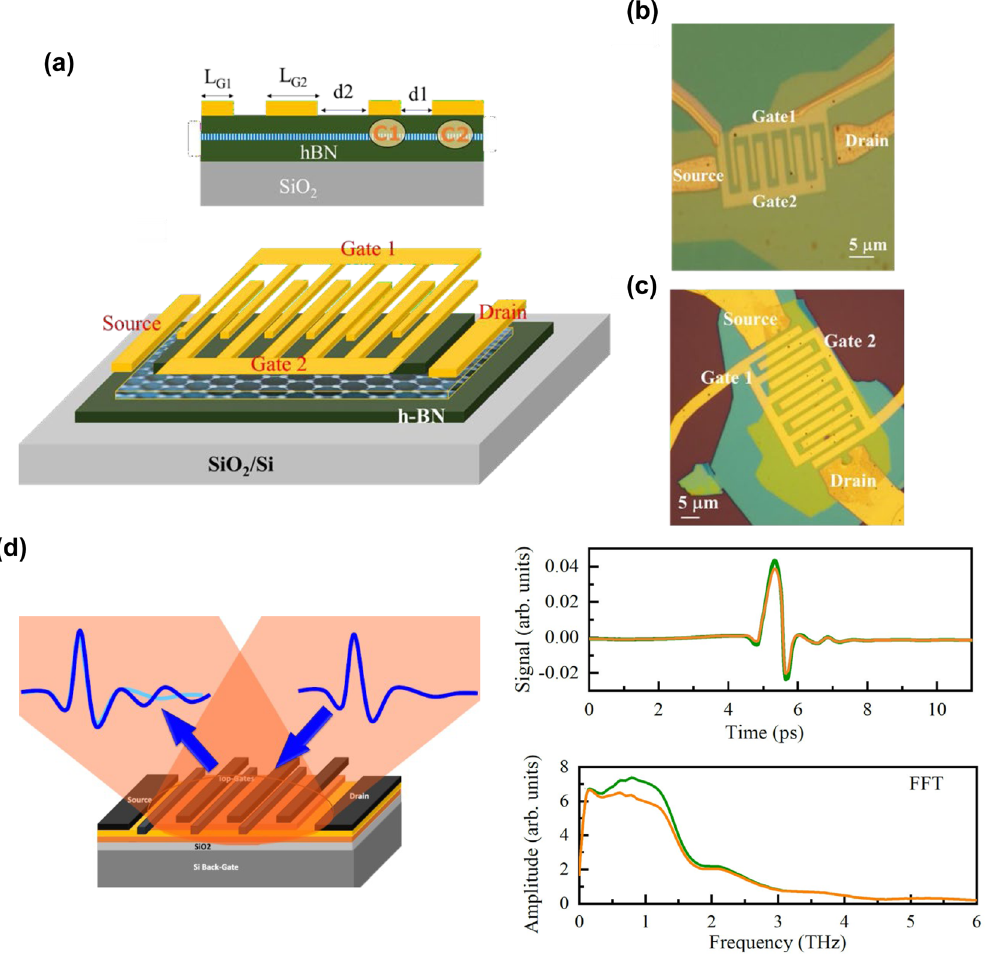
Figure 7: DGG-GFET samples for THz time-domain spectroscopic measurement. (a)SchematicillustratingofthehBN/graphene/hBNheterostructureasymmetricDGG-GFET.Adaptedwithpermissionfromref.[49].Copyright 2021,theAuthors,publishedbyFrontiersMediaSA.(b)OpticalimageofanasymmetricDGG-GFET(ADGG-1).Adaptedwithpermissionfromref. [49]. Copyright 2021, the Authors, published by Frontiers Media SA. (c) Optical image of the symmetric DGG-GFET (S-DGG). Adapted with permission from ref. [49]. Copyright 2021, the Authors, published by Frontiers Media SA. (d) Experimental geometry of incident THz pulse and transmitted/re fl ected pulse in an oblique angle (left) and measured temporal waveforms (right upper) and their Fourier spectra (right lower). Orange: incident, green: output. Adapted with permission from ref. [48]. Copyright 2020, the American Physical Society.